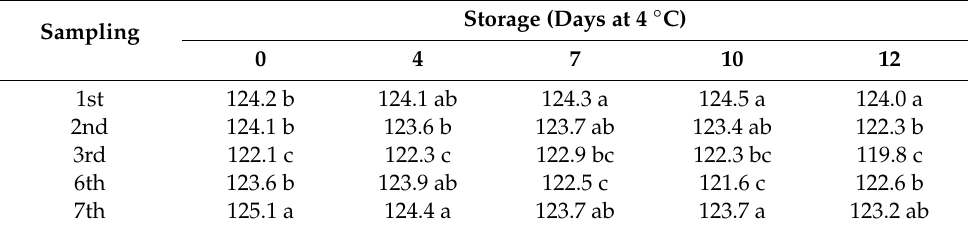
Table 5. Hue color parameter of baby spinach leaf during storage at 4 ◦ C for 12 days as a ff ected by growing season. Comparisons of the means were separately performed for each storage day. Means with di ff erent letters are significantly di ff erent ( a < 0.05).